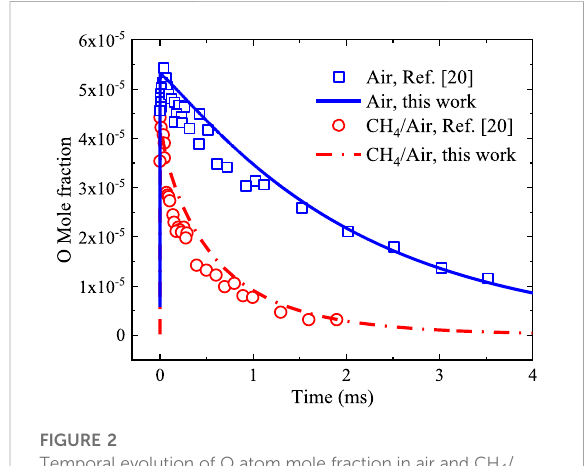
FIGURE 2 Temporal evolution of O atom mole fraction in air and CH 4 / air mixtures.